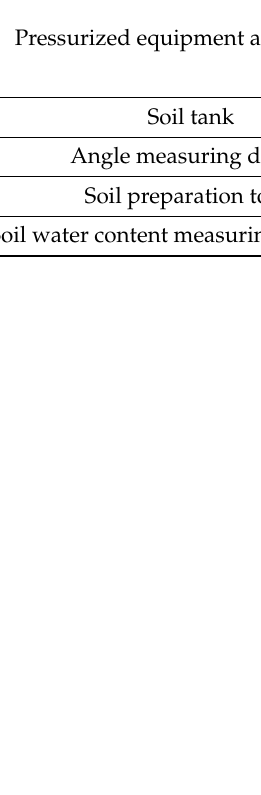
( b ) Figure 5. Pressure-sinkage curves of soil under different soil water contents and densities. ( a ) Influence of soil water content on curve when bulk density is 2 mg·m − 3 ; ( b ) Influence of bulk density on curve when soil water content is 7%. 2.3. Modification of Bekker’s Model under Sloped Terrain Conditions 2.3.1. Test Scheme and Principle In Bekker’s model, the sinkage parameters can be calculated from the pressure– sinkage curve. Therefore, the soil water content, bulk density, and slope angle were se- lected as the test factors, and the quadratic rotation orthogonal combination test was carried out to obtain the sinkage parameters of the four soil types. Because the plastic limit of agricultural soil does not typically exceed 16% [23], 4% and 16% were considered as the lower and upper limits of the soil water content, respec- tively. According to the abovementioned bulk density measurement results, the bulk density at the depth range of 0–30 cm is 1.84 mg·m − 3 at minimum and 2.26 mg·m − 3 at maximum. Therefore, 1.5 mg·m − 3 and 2.5 mg·m − 3 were considered as the lower and upper limits of the bulk density. Because a farmland slope greater than 20° will cause severe soil